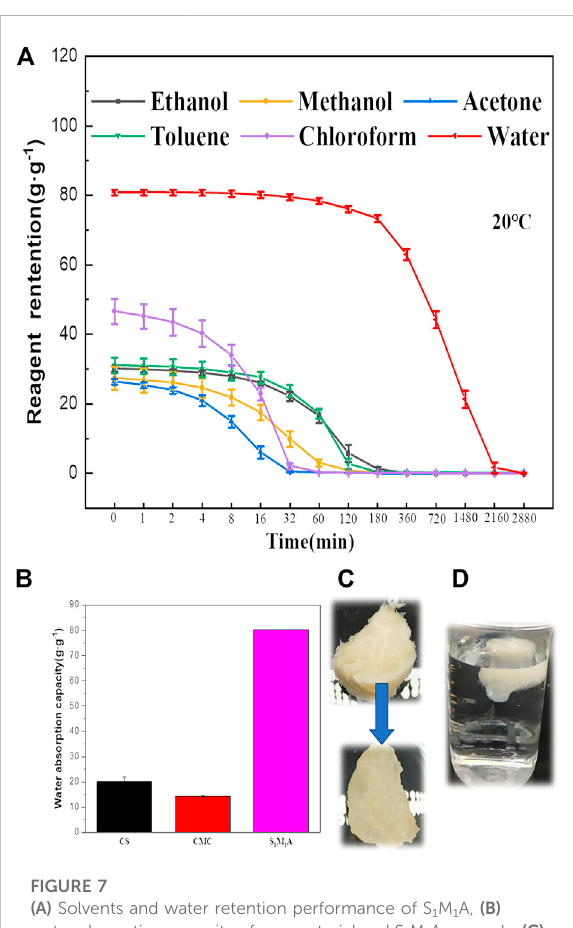
FIGURE 7 (A) Solvents and water retention performance of S 1 M 1 A, (B) water absorption capacity of raw material and S 1 M 1 A aerogels, (C) the aerogel before and after absorbing water, (D) the fl oating aerogel after water